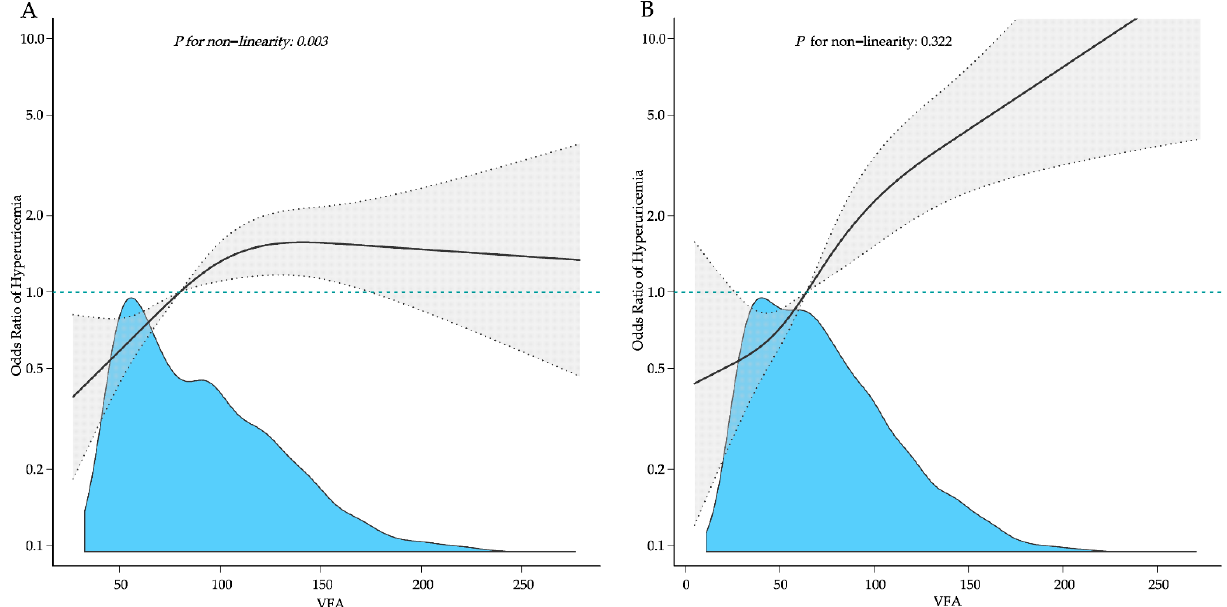
Figure 2. Adjusted dose-response association between the VFA and the risk of HUA with a restricted cubic spline function. ( A ) Males; ( B ) Females. Model with three knots located at the 5th, 50th, and 95th percentiles. The dashed lines represent 95% confidence intervals. Table 4. Threshold effect analysis of VFA and HUA in males using the two ‐ piecewise linear regres ‐ sion model.